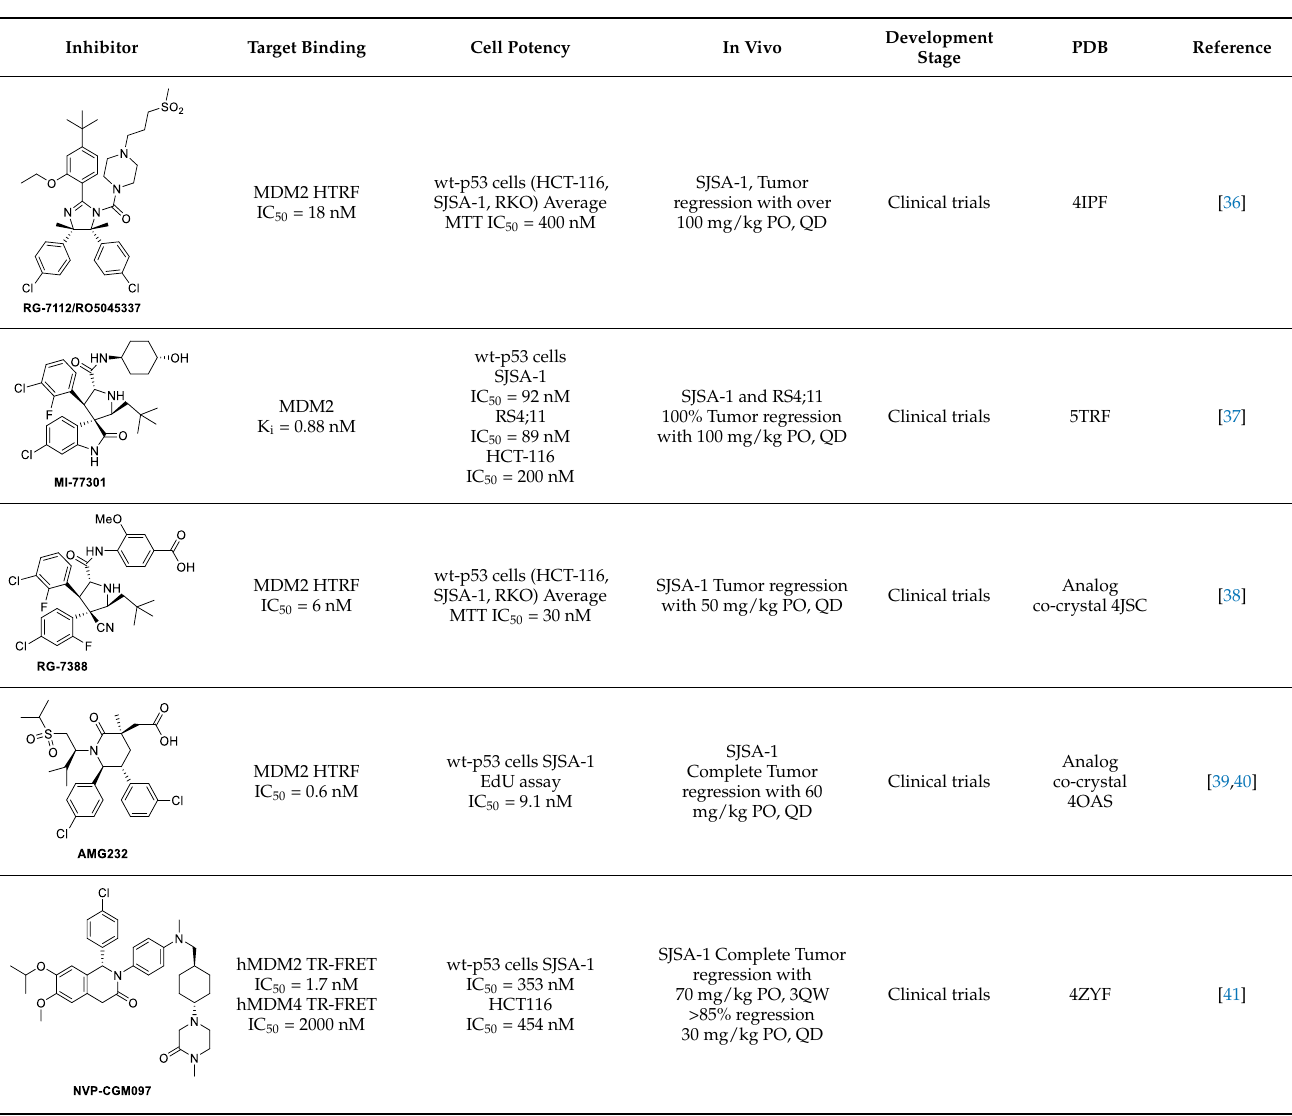
Table 1. Available data of MDM2 Table 1. Available data of MDM2 inhibitors. Table 1. Available data of MDM2 inhibitors. Table 1. Available data of MDM2 inhibitors. Table 1. Available data of MDM2 inhibitors. Inhibitor